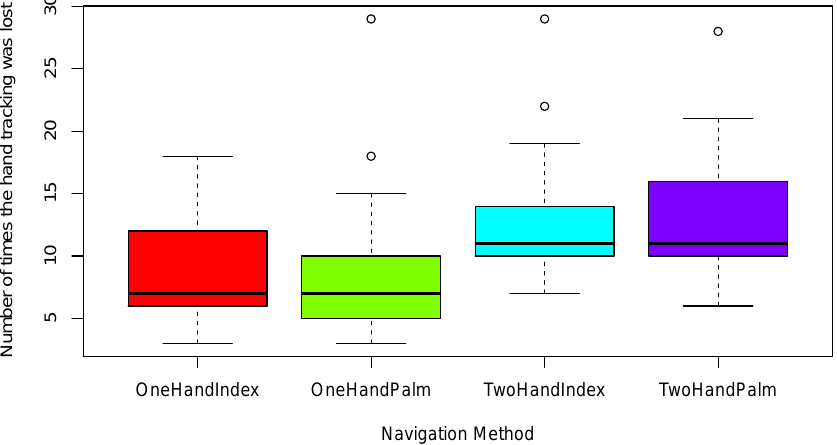
Figure 11. Boxplot for the number of times the hand tracking failed during the experimental